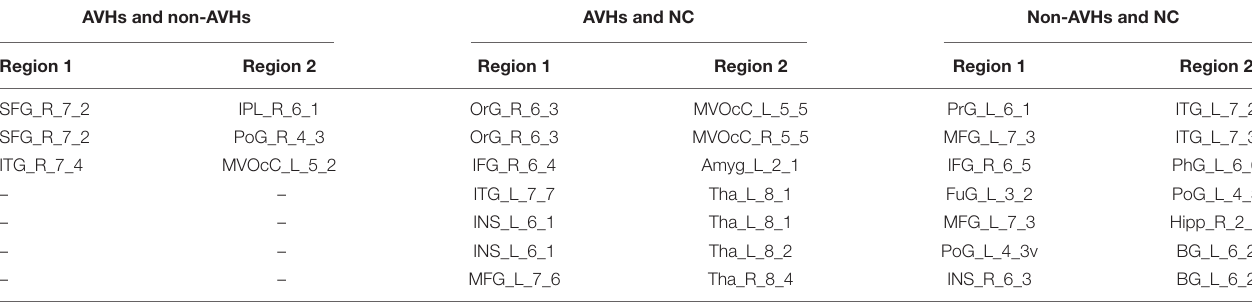
TABLE 6 | Significant differences in variances of the dynamic functional connectivity matrices obtained with global signal regression (overlap = 0.6). AVHs and non-AVHs AVHs and NC Region 1